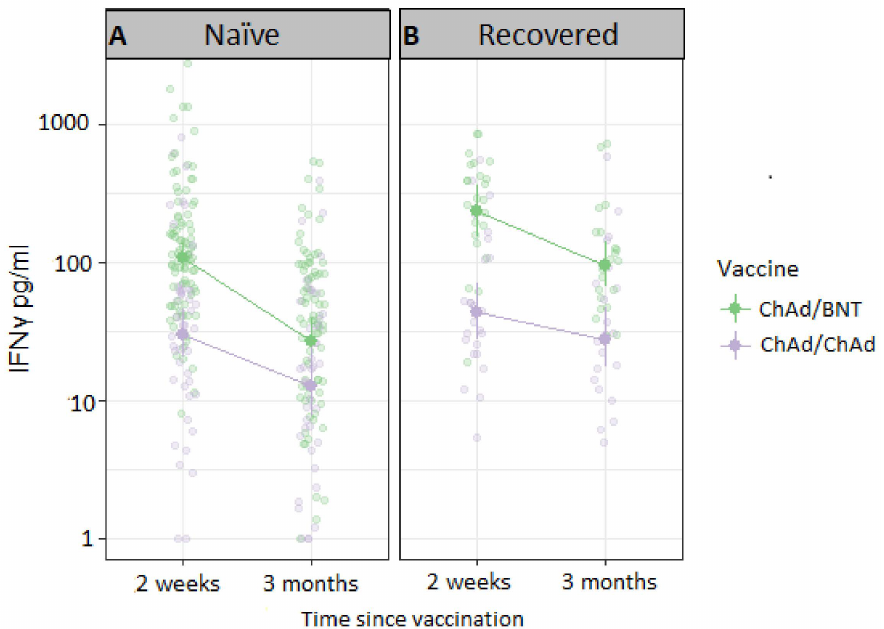
Figure 3. Concentration of background-adjusted interferon-gamma (IFN- γ ) levels after whole-blood stimulation with 16 SARS-CoV-2 specific peptides in serial sampling at 2 weeks (14–21 days) and 3 months (75–105 days) after vaccine in ( A ) SARS-CoV-2 naïve (ChAd/BNT n = 92, ChAd/ChAd n = 48) and ( B ) SARS-CoV-2 recovered (ChAd/BNT n = 25, ChAd/ChAd n = 25) participants. IFN- γ was measured by ELISA in the supernatant. Transparent circles represent individual samples, filled circles represent geometric mean with 95% CI. IFN- γ ; Interferon- γ , ChAd; ChAdOx1 nCoV-19 vaccine, BNT; BNT162b2 mRNA